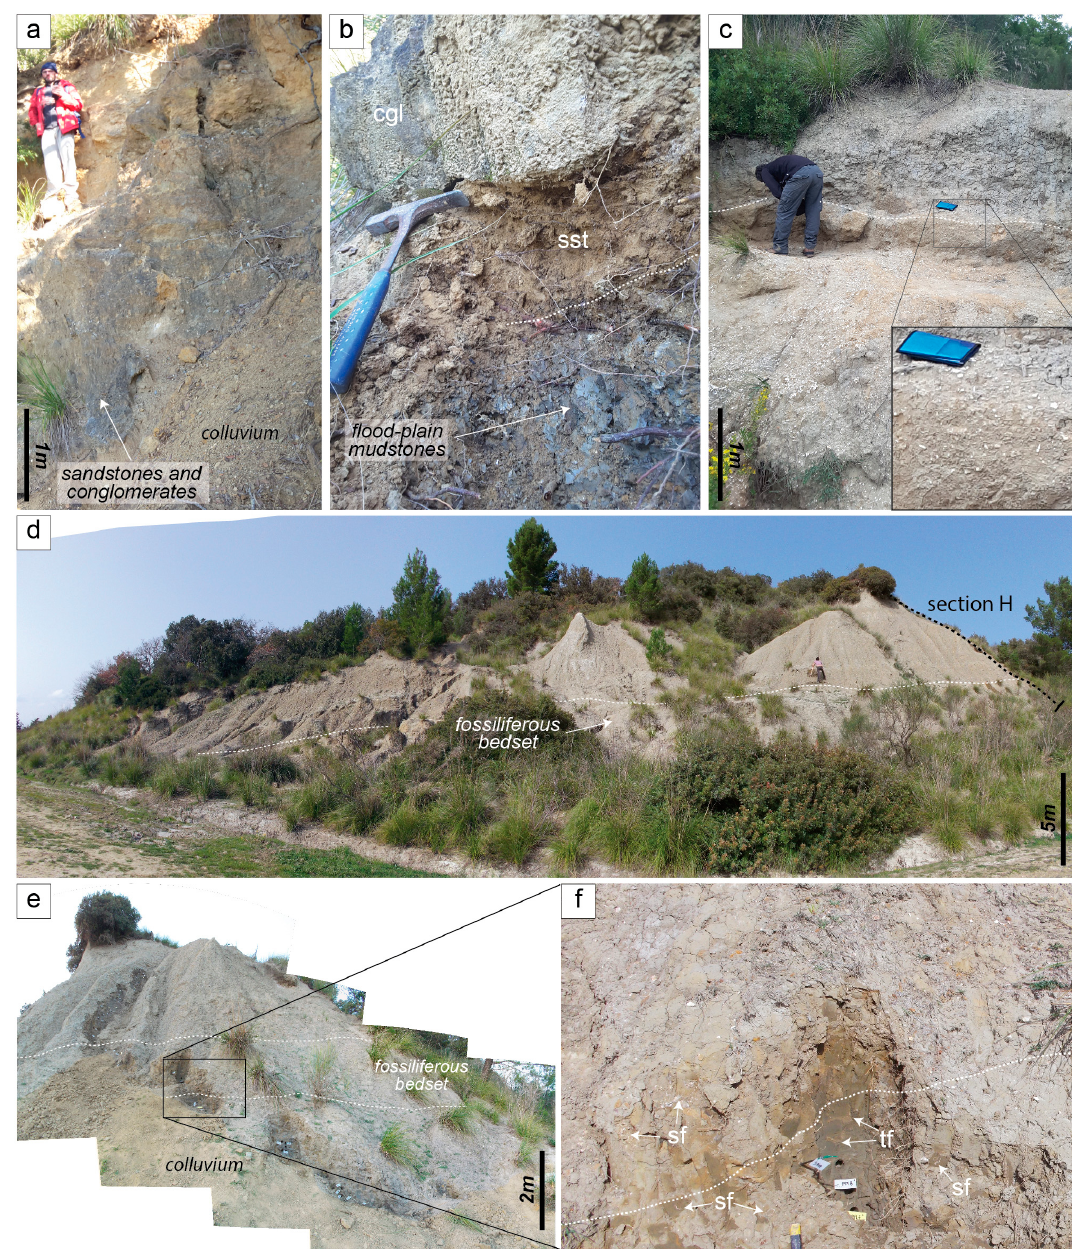
Figure 4. ( a ) The amalgamated bedset of marine sandstones (sst) and conglomerates (cgl) of